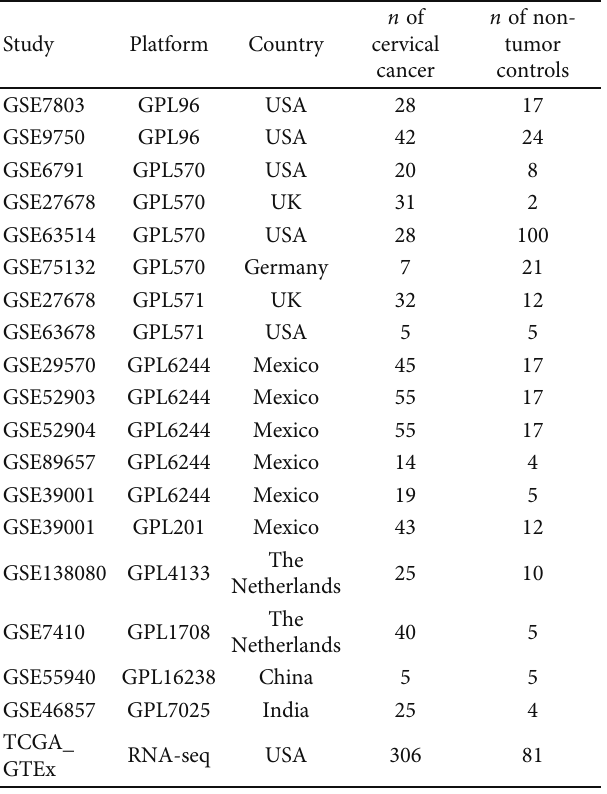
Table 4: Basic information of included microarray and RNA-seq